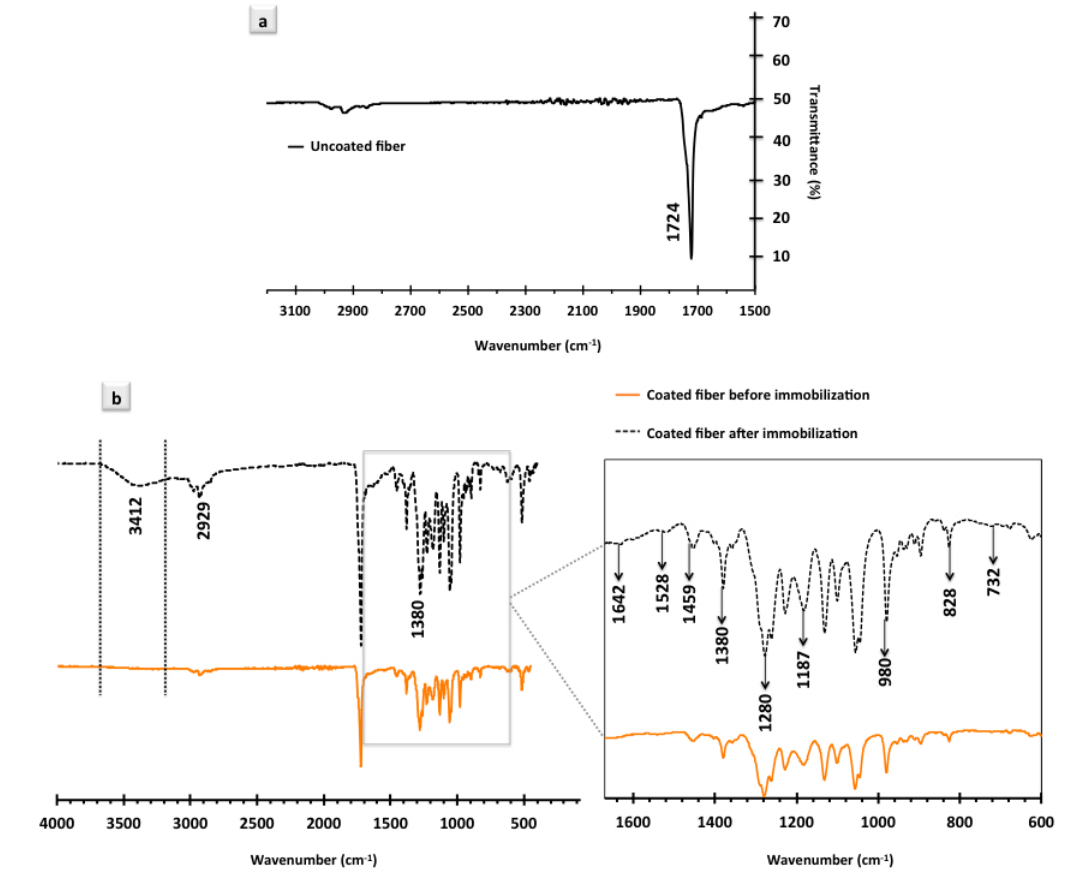
Figure 4. FTIR analysis of the uncoated and coated electrospun PHB fibers: FTIR spectrum of ( a ) pure PHB fibers; ( b ) co-polymer coated PHB fibers before and after protein immobilization. Zoomed-in area is the finger print region of the